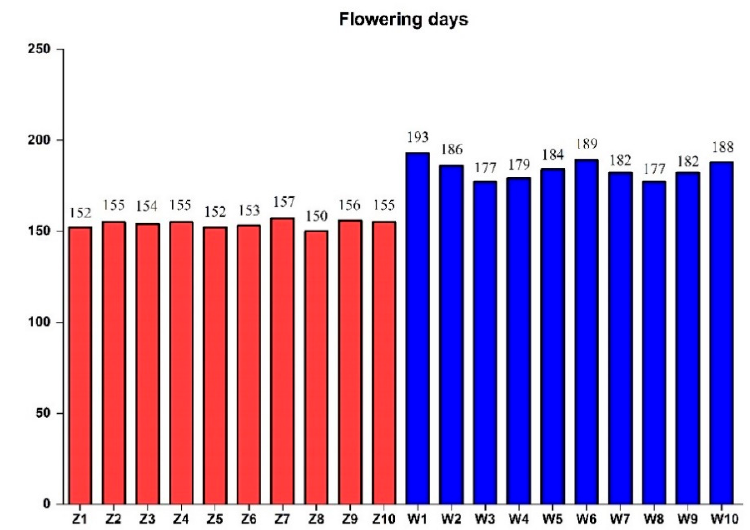
Figure 4. The flowering days of 20 E. sibiricus germplasms from 1 January